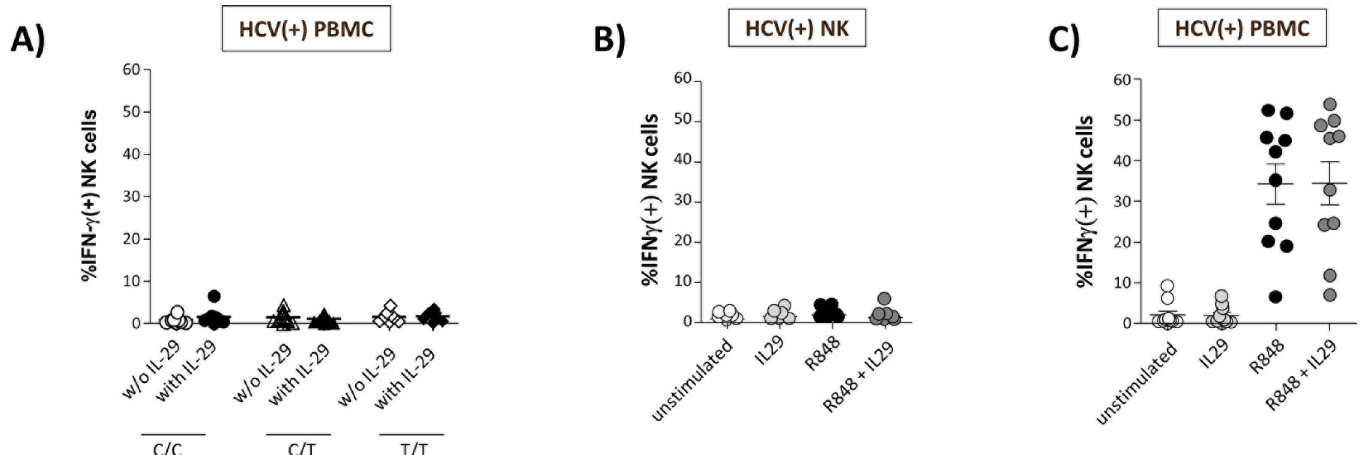
Fig 1. Human NK cells are insensitive to stimulation with IL-29. Purified NK cells from HCV(+) patients carrying an IL-28B C/C (n = 8), C/T (n = 12), or T/T (n = 7) genotype where cultured in the presence or absence of IL-29 (100ng/ml) overnight, then co-cultured with HuH7 HCV Replicon cells for 5h and tested for IFN- γ production (A ). Total PBMC (n = 27) (B) from HCV(+) patients were stimulated with IL-29 (100ng/ml), R848 (200ng/ml), or a combination of both overnight. Then, PBMC were co-cultured with HuH7 HCV Replicon cells for 5h and tested for IFN- γ